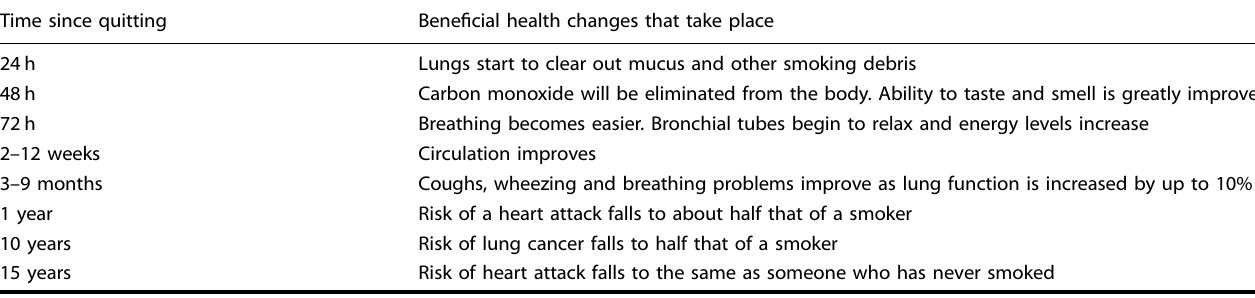
Table 1. Health bene fi ts of smoking cessations Time since